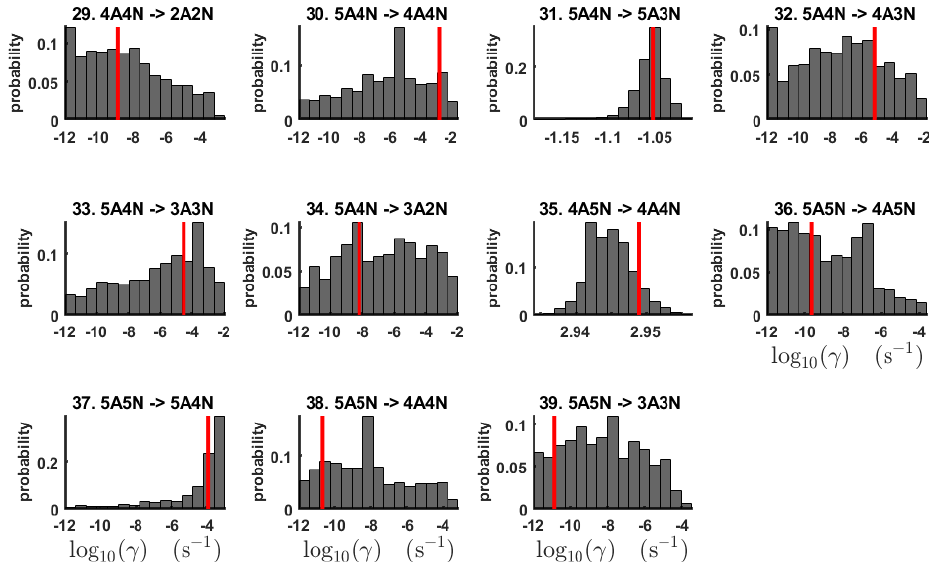
Figure 4. One-dimensional marginal posterior distributions (for parameter indexes ranging from 29 to 39) of the base 10 logarithm of the evaporation rates (units given in s − 1 ) determined from steady-state cluster concentration measurements at the temperature 278K. Red lines denote the baseline values from Olenius et al. (2013b) used to generate the synthetic data. The notation xAyN corresponds to a cluster with x sulfuric acid and y ammonia molecules.